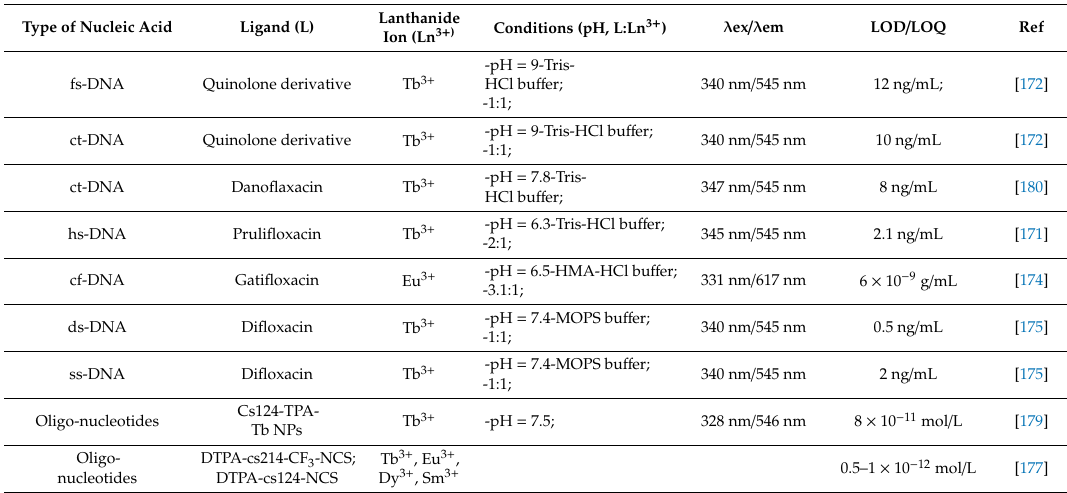
Table 6. Determination of DNA using quinolone–lanthanide